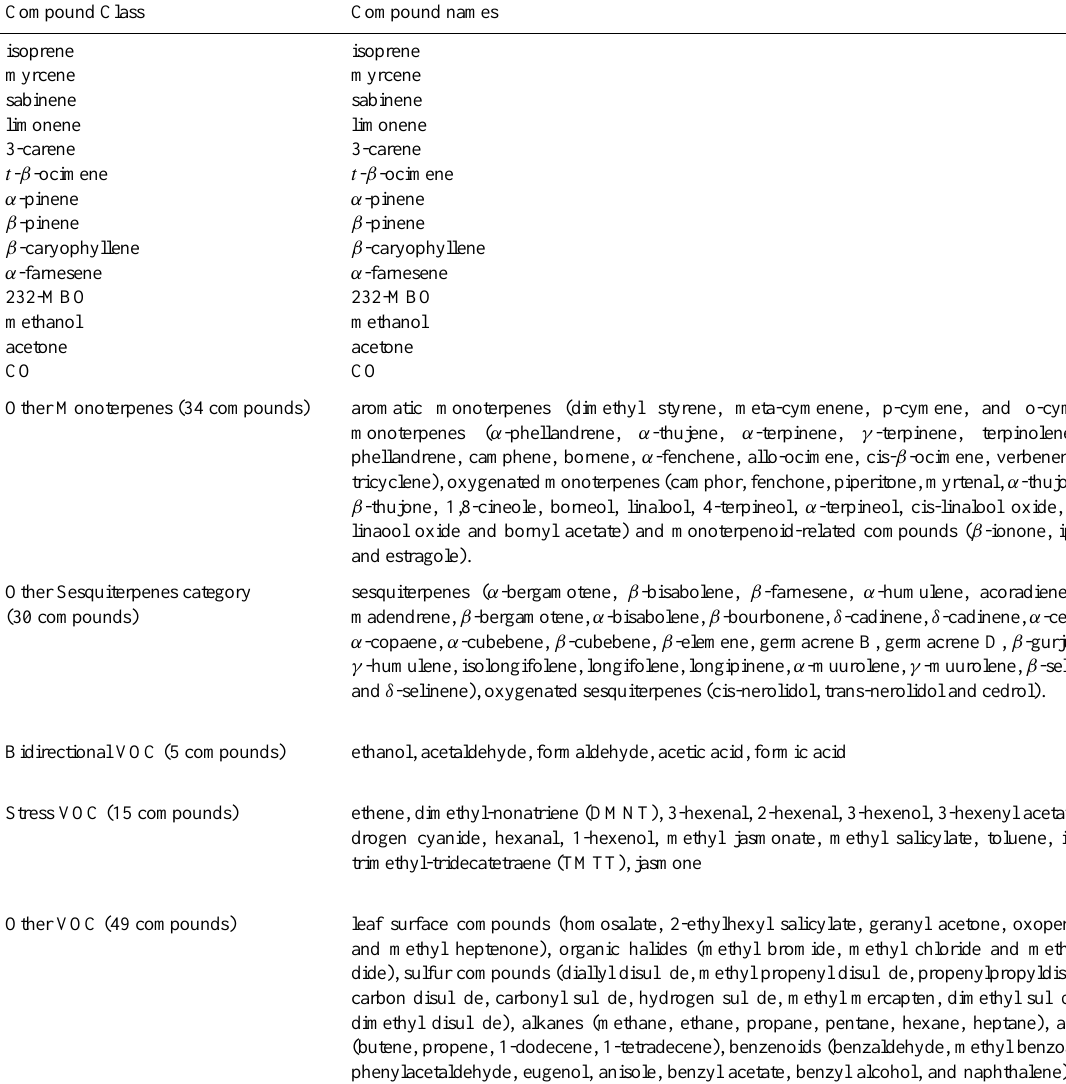
Table 1. MEGAN2.1 compound classes and individual